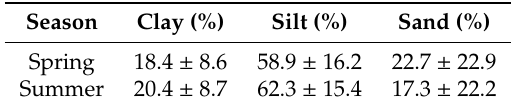
Figure 2. Ternary diagram showing the Shepard’s classification and textures of the surface sediments in spring and summer. Table 1. Mean values (mean ± SD) of the grain size fractions for the full sampling sites in the Zhanjiang Bay in spring and